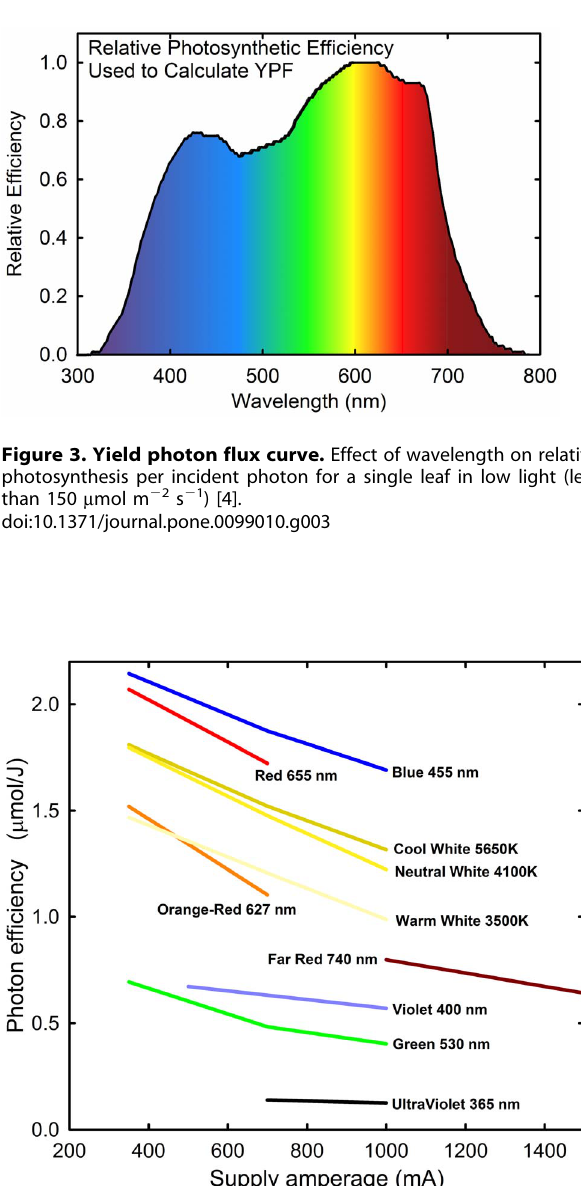
Table 1. Efficiency of individual LEDs at a drive current of 700 mA.